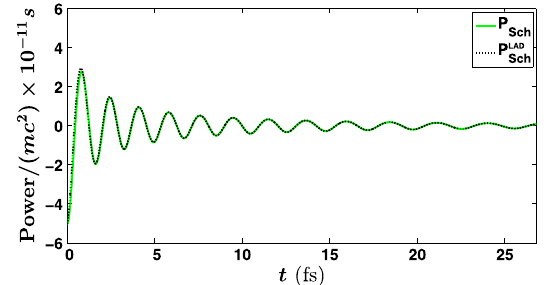
ð t Þ and P LAD ð t Þ for the uniform circularly FIG. 11. P Sch Sch polarized plane wave with parameters given in Fig.